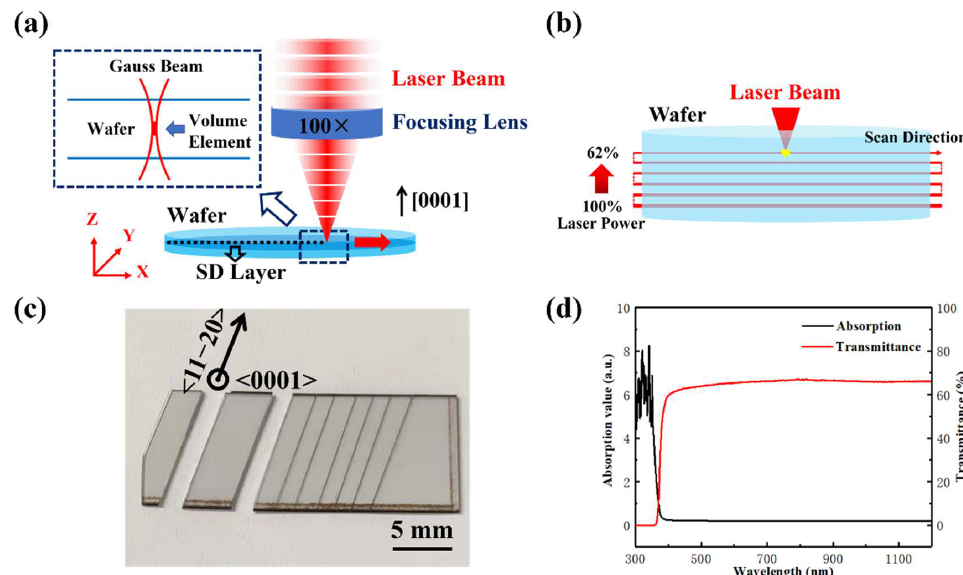
Figure 1. ( a ) Schematic diagram of ultrafast laser scanning in the SiC wafer and ( b ) PLSD. ( c ) The semi-insulated 4H-SiC wafer sample after PLSD. ( d ) Absorption and transmission spectra of the wafer at 300–1200 nm.